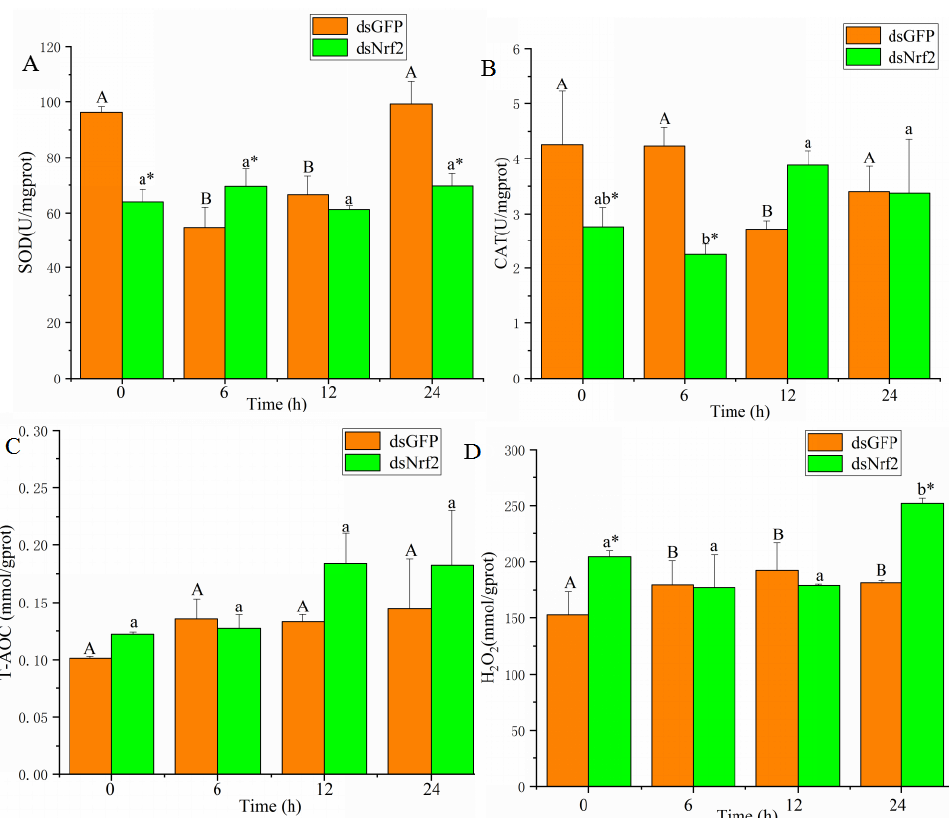
Figure 5. SOD ( A ), CAT ( B ), T-AOC ( C ), and H 2 O 2 ( D ) in the dsNrf2 group and the dsGFP group after cadmium exposure. Values are expressed as the mean ± SD. Significant differences between the dsNrf2 group and the dsGFP group at each time are indicated by asterisks. Times in each group that have different letters were significantly different (* p < 0.05).